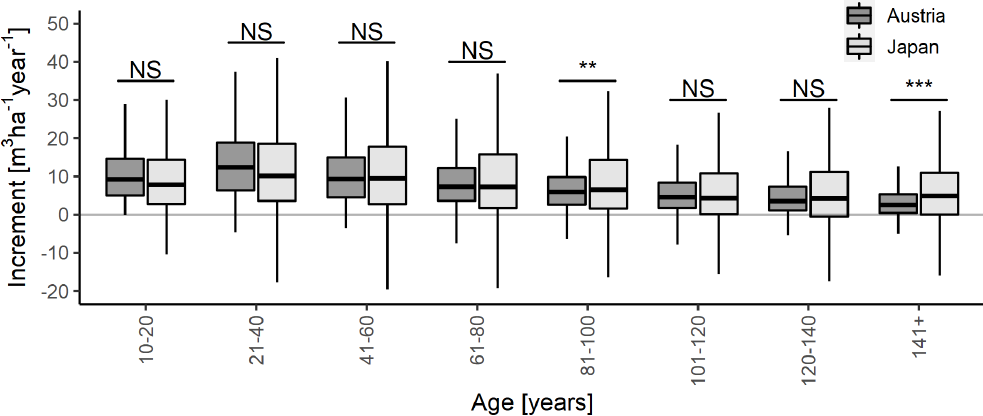
Figure 6. Increment according to age class. Mean increments were tested (Welch two-sample t -test) for significant differences in the same age class between Austria and Japan (NS: p > 0.05, ** p ≤ 0.01, *** p ≤ 0.001). Trees younger than 10 years old were excluded because DBHs smaller than 5 cm are not measured in the ANFI. The black line that divides the box into two parts represents the median. The ends of the box show the lower ( bottom ) and upper ( top ) quartiles. The vertical lines show the lowest and highest values, excluding potential outliers. Data are from the Austrian National Forest Inventory (2002, 2009) and Japanese National Forest Inventory (2007, 2011).